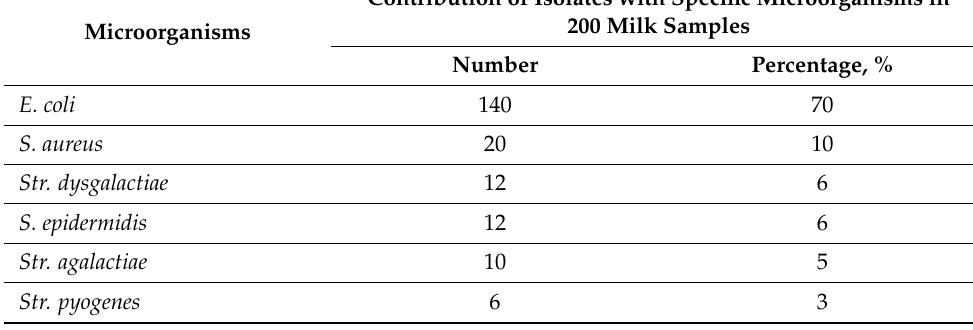
Table 1. Results of the microbiological study of milk samples from 200 cows with serous mastitis. Contribution of Isolates with Specific Microorganisms in Microorganisms